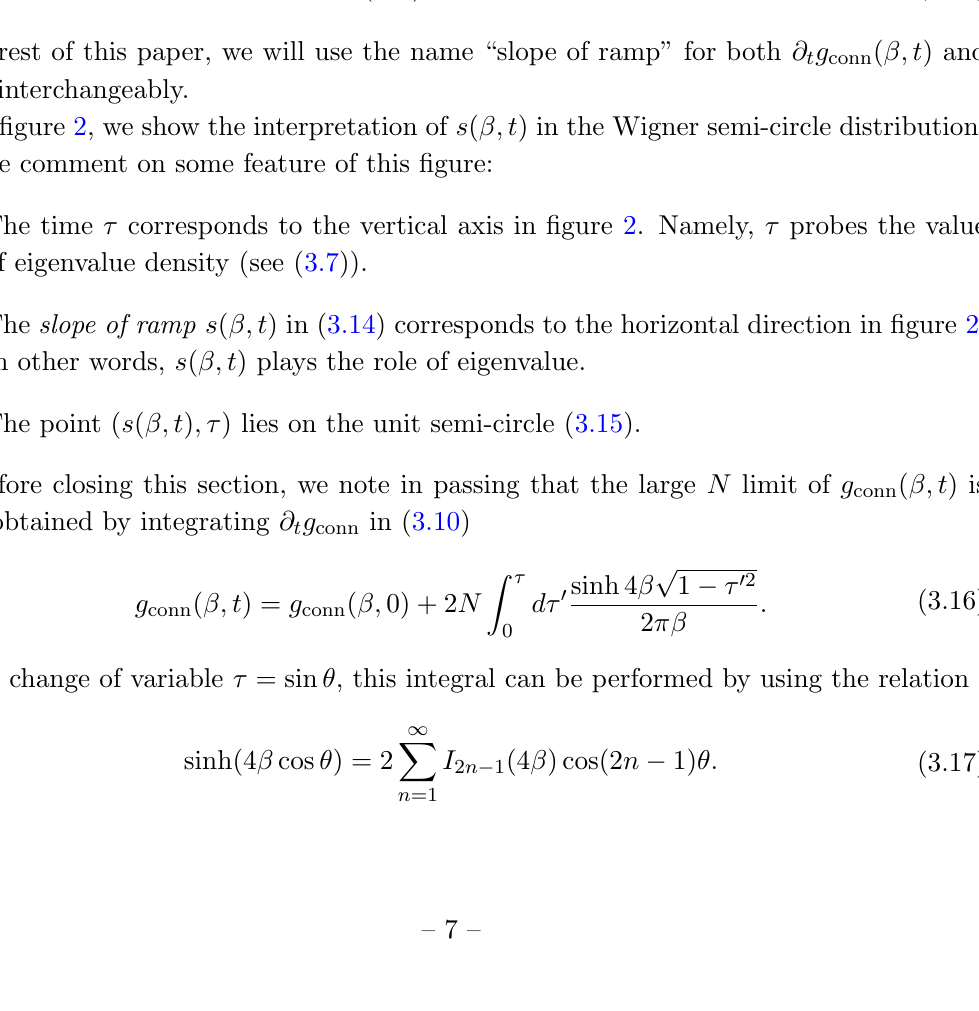
Figure 2. This (cid:12)gure shows the interpretation of (cid:28) and s ( (cid:12); t ) in the eigenvalue distribution. The blue semi-circle is the graph of eigenvalue density (cid:25)(cid:26) (2 u ) = represented by the horizontal red line. The slope of ramp s ( (cid:12); t ) = u (cid:28) corresponds to the length of solid red